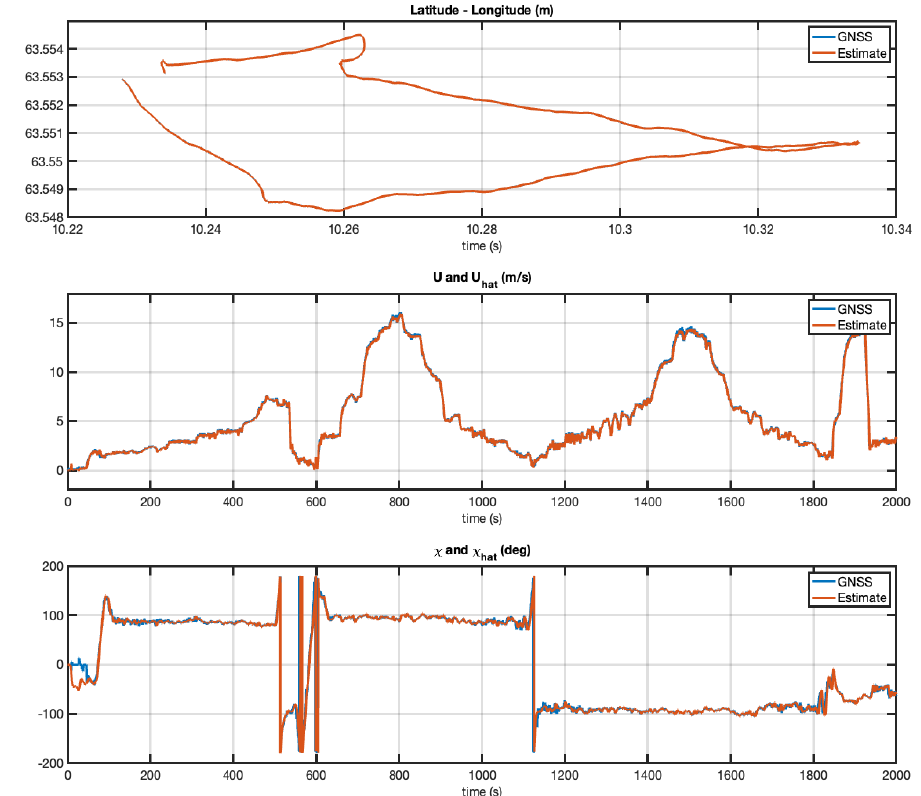
Figure 8. Experiment with the Mariner USV. Estimated SOG and COG versus time using latitude and longitude measurements at 5 Hz. Both the GNSS receiver and the EKF estimate the SOG and COG quite well for speeds higher than 1 m/s. The only discrepancy is during start up (low